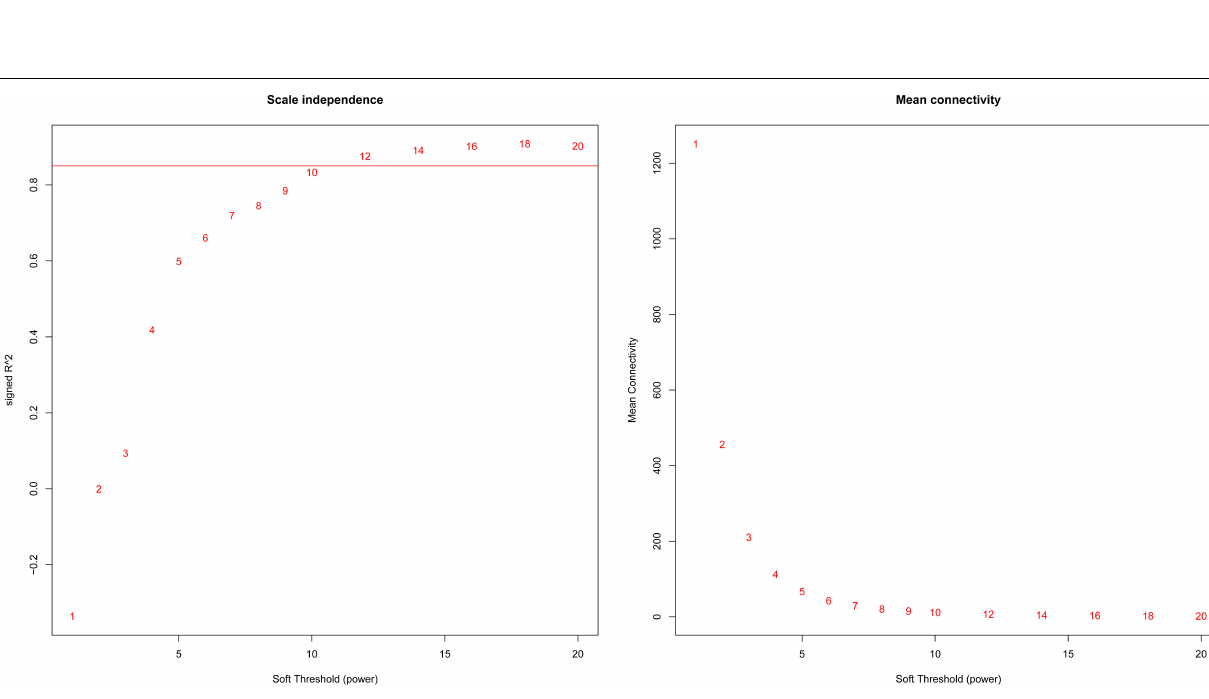
FIGURE 2 | Analysis of network topology for various soft-theholding powers. The left panel shows the scale-free fit index, signed Rˆ 2 (y-axis) and the soft threshold power (x-axis). β = 12 was chosen for subsequent analysis. The right panel shows the mean connectivity (y-axis) is a strictly decreasing function of the power β